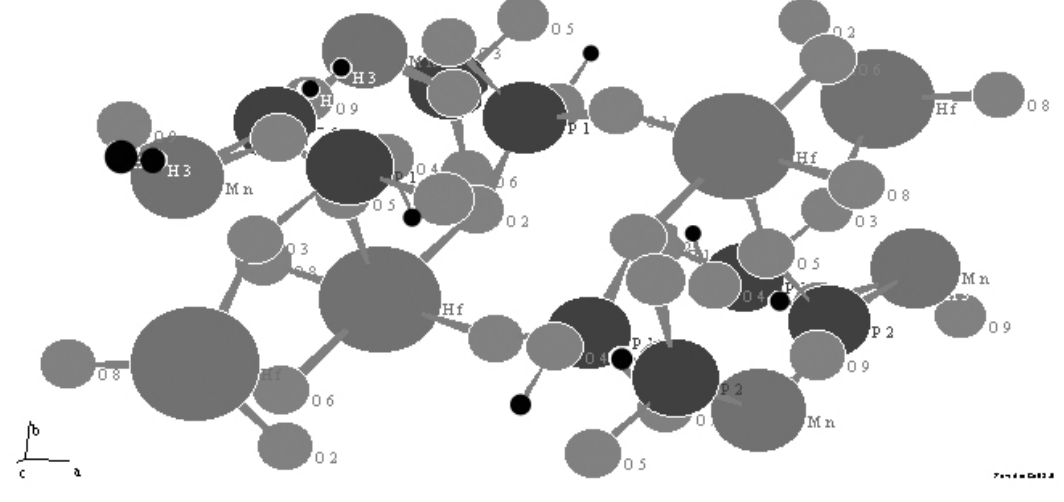
Fig. 5 The 001 projection of Mn(II) containing α -hafnium phosphate